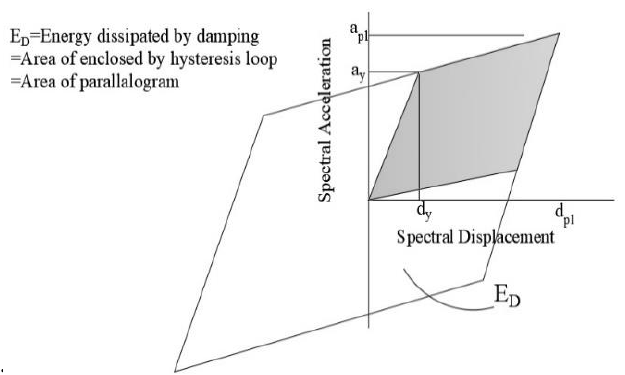
Fig. 4. E is the Energy Dissipated by Damping Derivation (ATC-40, 1996). D